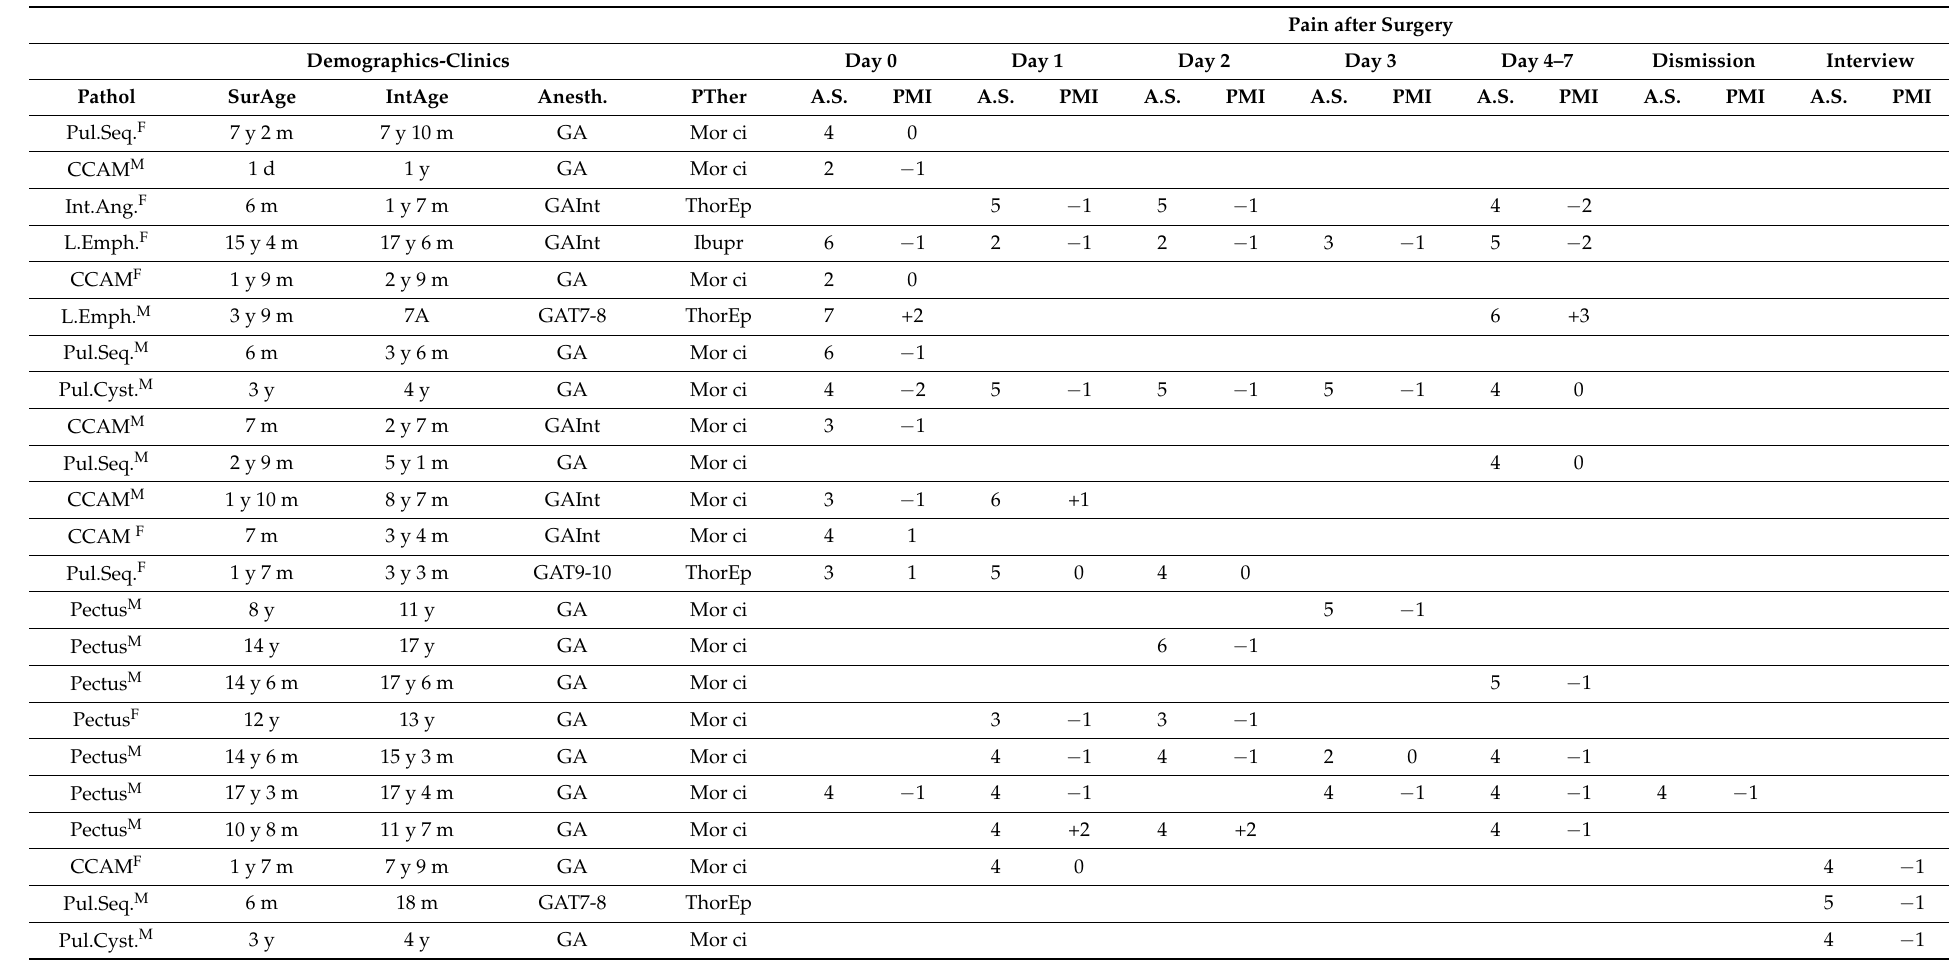
Table 4. Trajectories of pain and